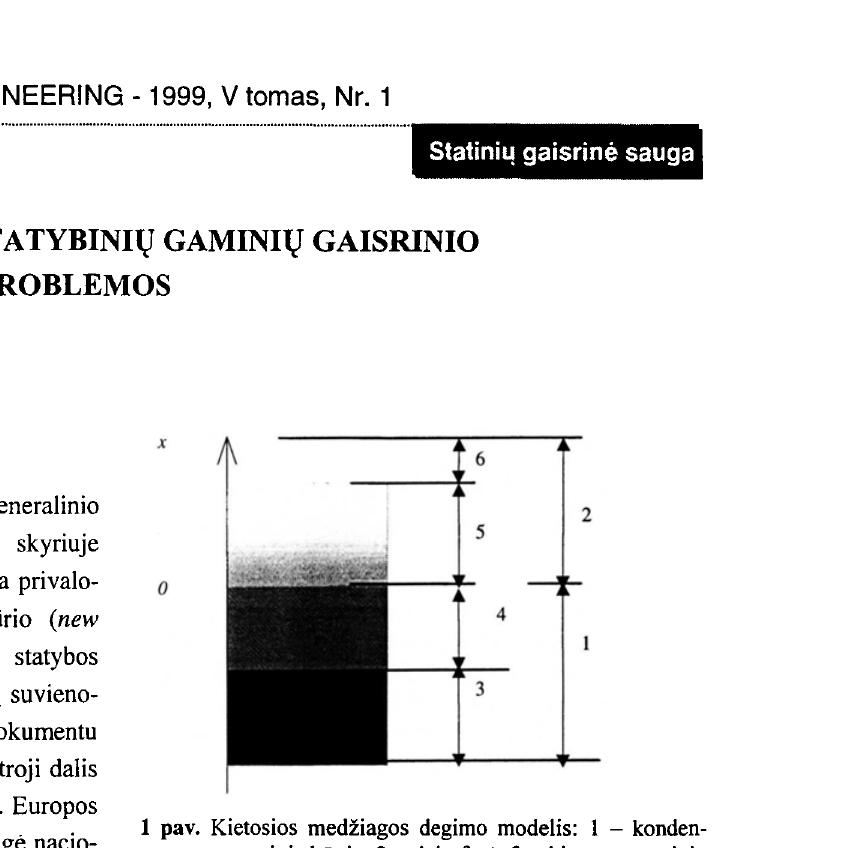
Fig 1. The model of combustion of the solid material: I - condensation phase; 2 - gas-phase; 3 - non-reaction zone in the condensation phase; 4 - reaction zone in the vapour condensation phase; 5 - reaction zone in gas-phase; 6 - gaseous combustion